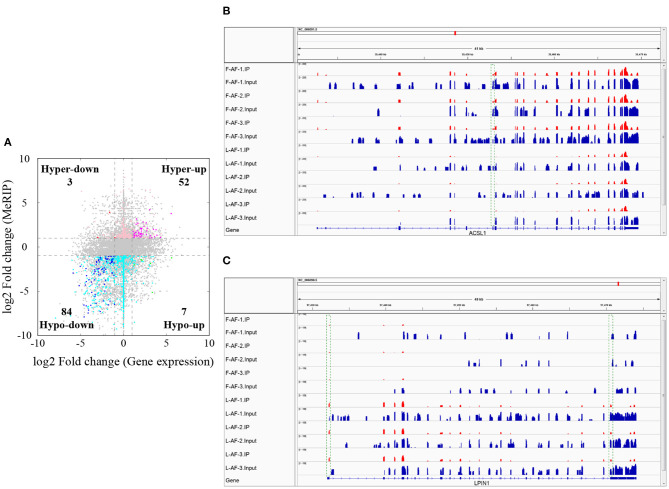
Relationship between m6A content and mRNA levels in adipose tissue of broiler chickens. (A) Distribution of genes with a marked change in both mRNA expression and m6A methylation in fat-line compared with lean-line chickens. (B) The abundance of m6A in the ACSL1 mRNA transcripts of fat (F-AF-1, F-AF-2, and F-AF-3) and lean (L-AF-1, L-AF-2, and L-AF-3) birds, as detected by MeRIP-seq. The intensity of the m6A peak shown in the green rectangle is markedly higher in fat birds compared with lean birds. (C) The abundance of m6A in the LPIN1 mRNA transcript in fat and lean birds, as detected by MeRIP-seq. The intensities of the m6A peaks shown in the green rectangles are markedly lower in fat birds compared with lean birds.